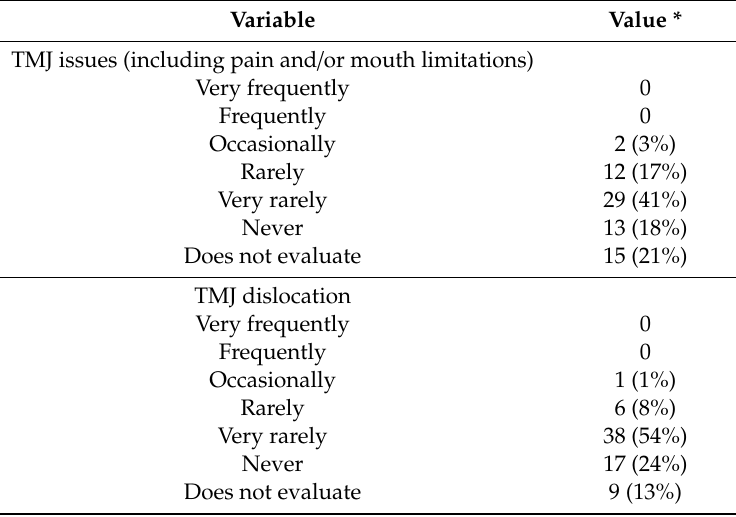
Table 3. Reported frequency of TMJ issues and dislocation